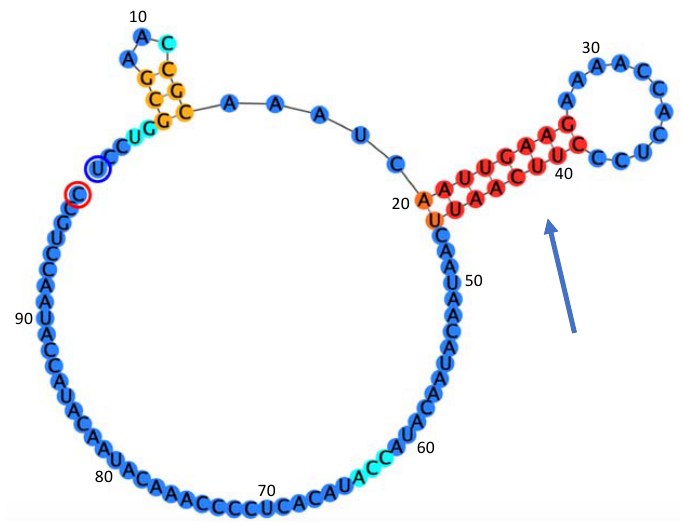
Figure 2. Prediction of the 5 ′ UTR secondary structure computed by RNAfold implemented in Geneious Prime 2020. The blue arrow indicates the stem ‐ loop that is predicted to remain stable up to 64 °C with a free energy of the thermodynamic ensemble ∆ G = − 2.58 kcal/mol in 1 M NaCl. The color of the nucleotides is related to the base pair probabilities provided by RNAFold: red, very high; orange, high; blue, low.